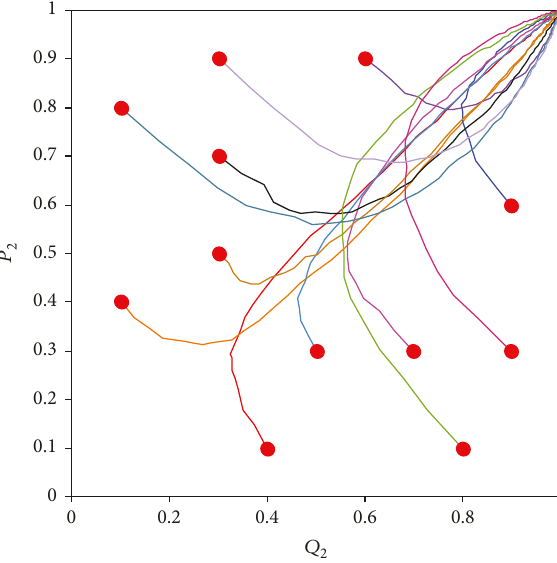
Q Figure 6: P 2 and 2 during the learning process of EAQR in Case 1 ( ε = 0 ).